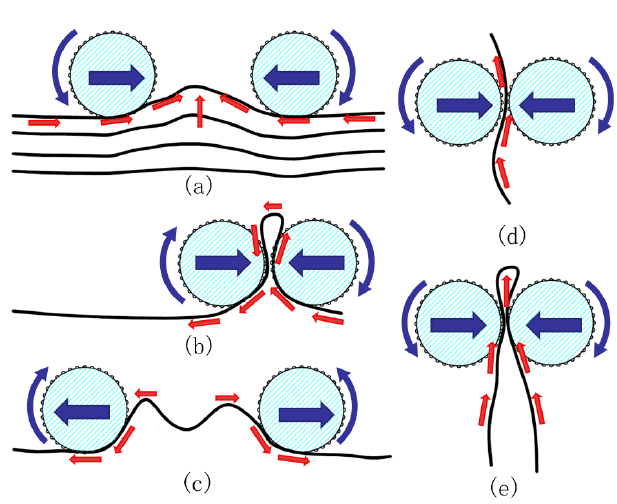
Figure 3. Schematic diagram of roller fingertips cooperating with grabbing. (a) The rollers on both sides roll against each other and move to the center so that the center of the fabric in the multi-layer tiled state arches to realize the grabbing of the arched part. (b) When grabbing the corner of the fabric, the rotation speed of the roller near the edge is slightly higher, and the differential rotation of the two rollers makes the fabric at the edge bulge. After clamping the bulge, the roller continues to rotate at a differential speed, so that the roller near the edge transports all the fabric to the middle of the two rollers and finally clamps the corner of the fabric, making it convenient for the subsequent stretching operation. (c) The two rollers rotate reversely and move to both sides at the same time, and the fabric can be stretched to both sides by the friction of the rollers on the leather, thus achieving the spreading effect. (d) When grab- bing and clamping the single-layer fabric, the grabbing position can be adjusted by rotating the two rollers at the same speed. (e) When grabbing fabric folds or clamping multi-layer fabrics, the grabbing position can be adjusted and the grabbing posture of leather can be changed partly by controlling the rotation direction and speed of the two